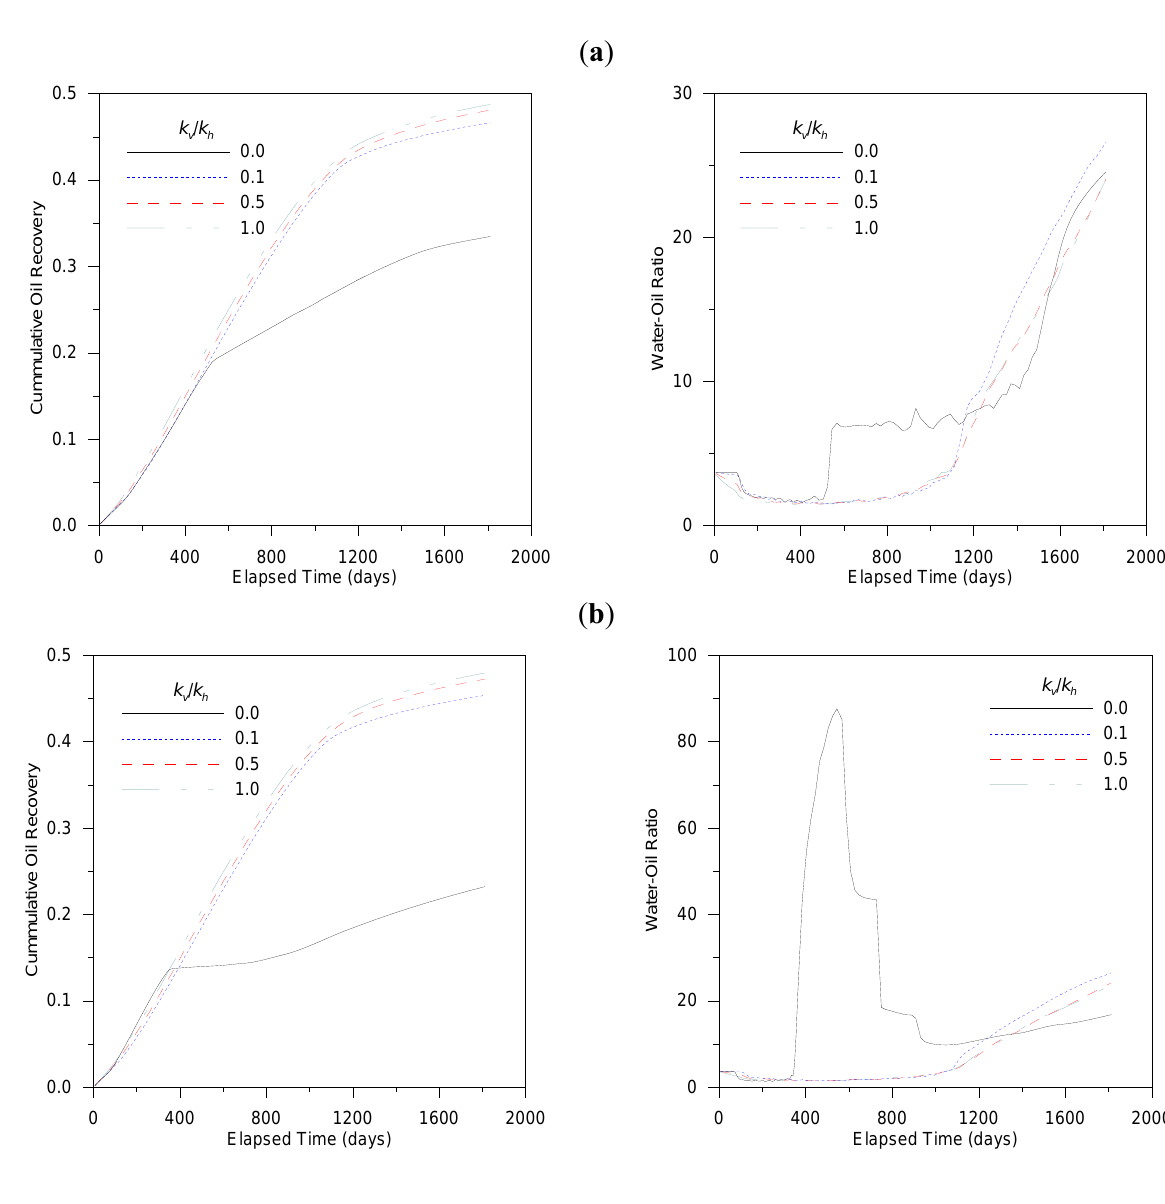
Figure 6. History of production wells obtained from simulations for heterogeneous reservoir of ( ) 5697.1ln = k σ with different ( b ) 6.2 = P . α